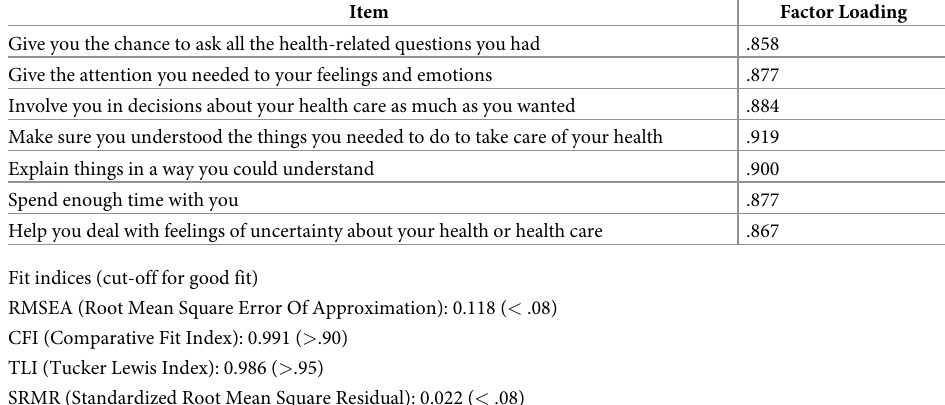
Table 3. Standardized factor loadings and fit statistics for confirmatory factor analysis of the PCC